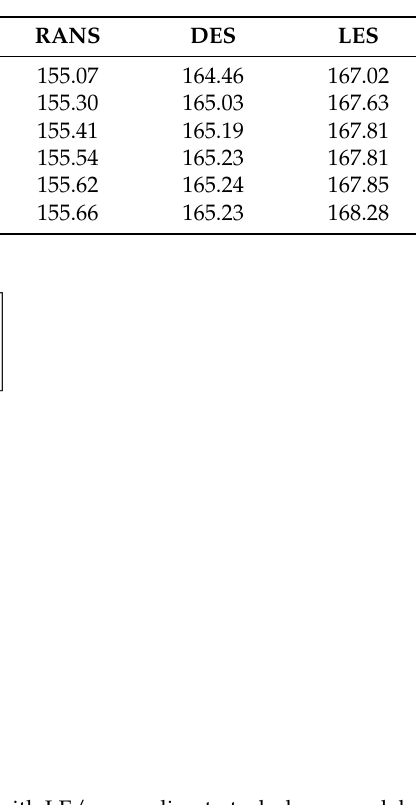
Figure 9. Geometry of Delft Twist11 hydrofoil and location of probes 1 to 6. Table 8. The results of SPL of wall pressure.